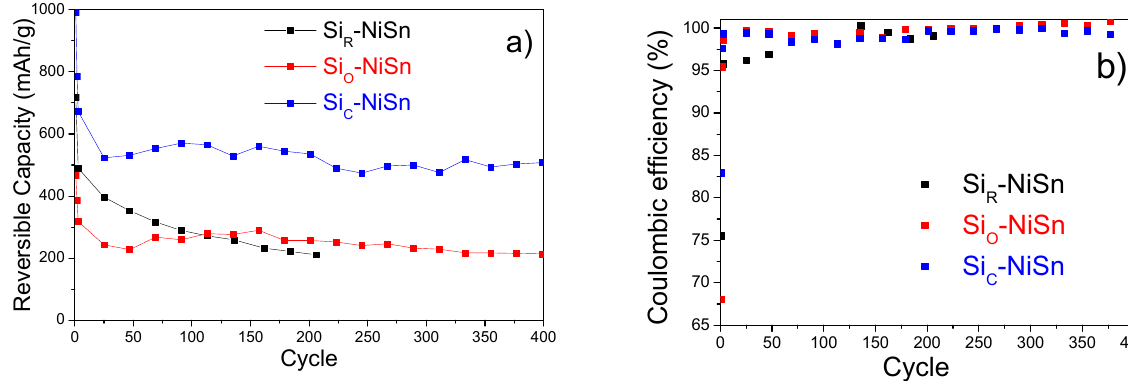
Figure 6. Evolution of the specific reversible capacity ( a ) and coulombic efficiency ( b ) of Si R -NiSn, Si O -NiSn and Si C -NiSn composites during galvanostatic cycling.